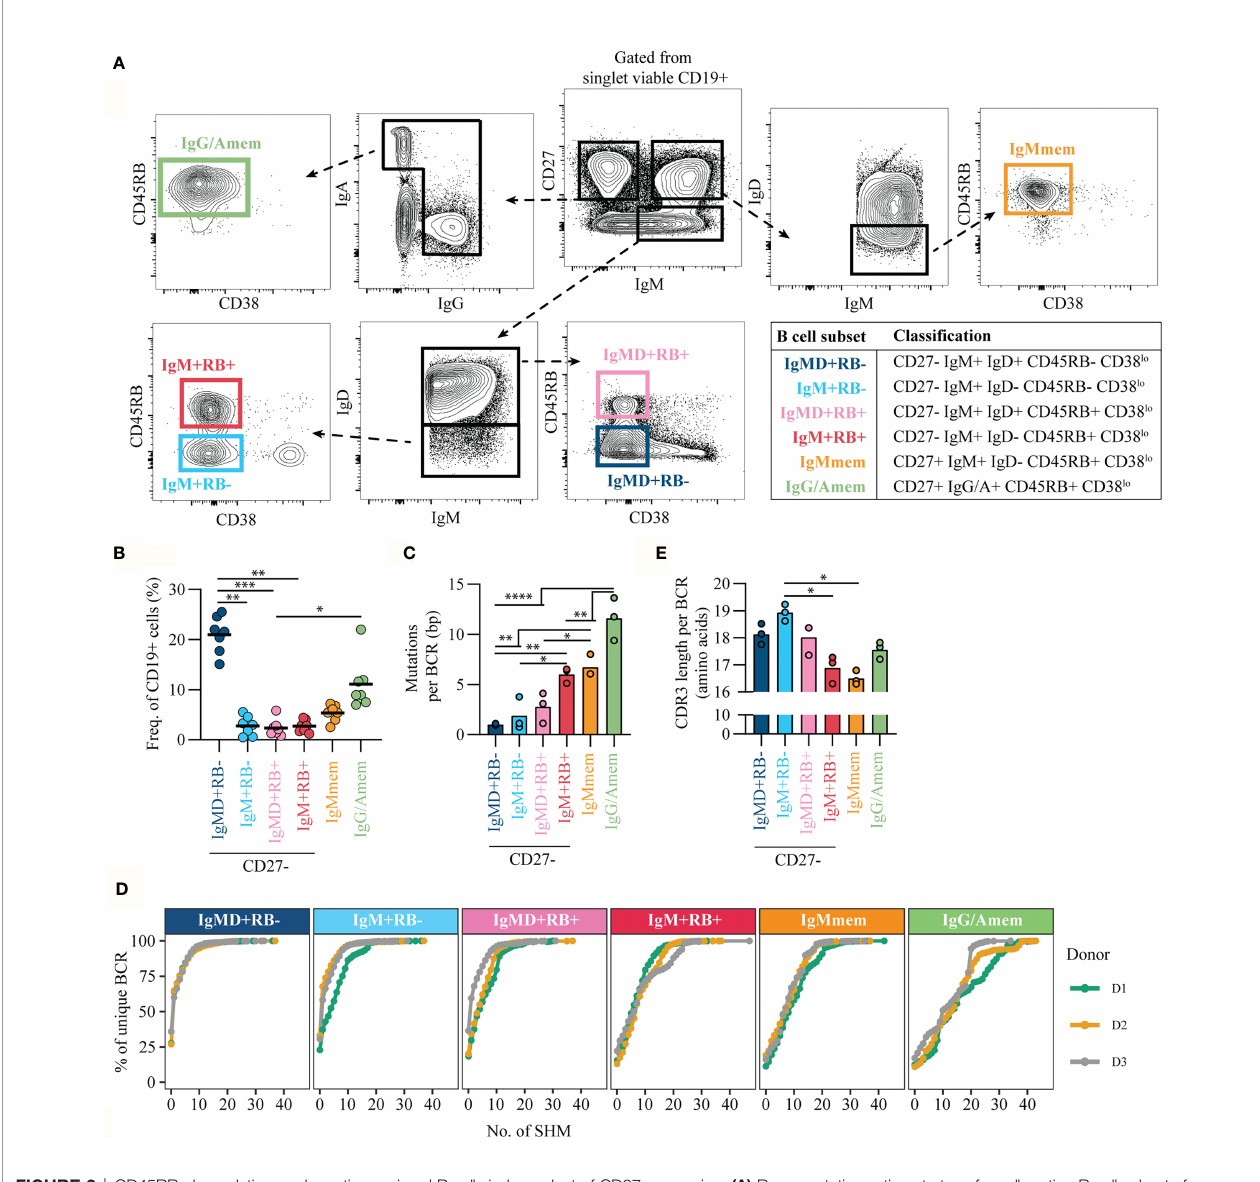
FIGURE 2 | CD45RB glycosylation marks antigen-primed B cells independent of CD27 expression. (A) Representative gating strategy for cell-sorting B cell subsets from healthy donor peripheral blood CD19+ pre-isolated B cells by fl ow cytometry. Gated from singlet viable CD19+ cells ( Figure S1B ). Table shows the classi fi cation of subsets. (B) Frequency of subsets within CD19+ cells, for seven biological replicates each composed of two technical replicates over three independent experiments. (C) Mean number of mutations per Ig gene (healthy adults, n = 3) and (D) Cumulative frequency distribution of mutations in the Ig repertoire in the different B cell subsets. Different colored lines represent different donors. (E) mean V H -CDR3 length from cell-sorted B cell subsets (healthy adults, n = 3). Bars and black lines depict mean values. Statistical differences were determined using a Friedman analysis of variance and Dunn ’ s multiple comparison test. *p < 0.05, **p < 0.01, ***p < 0.001, ****p <